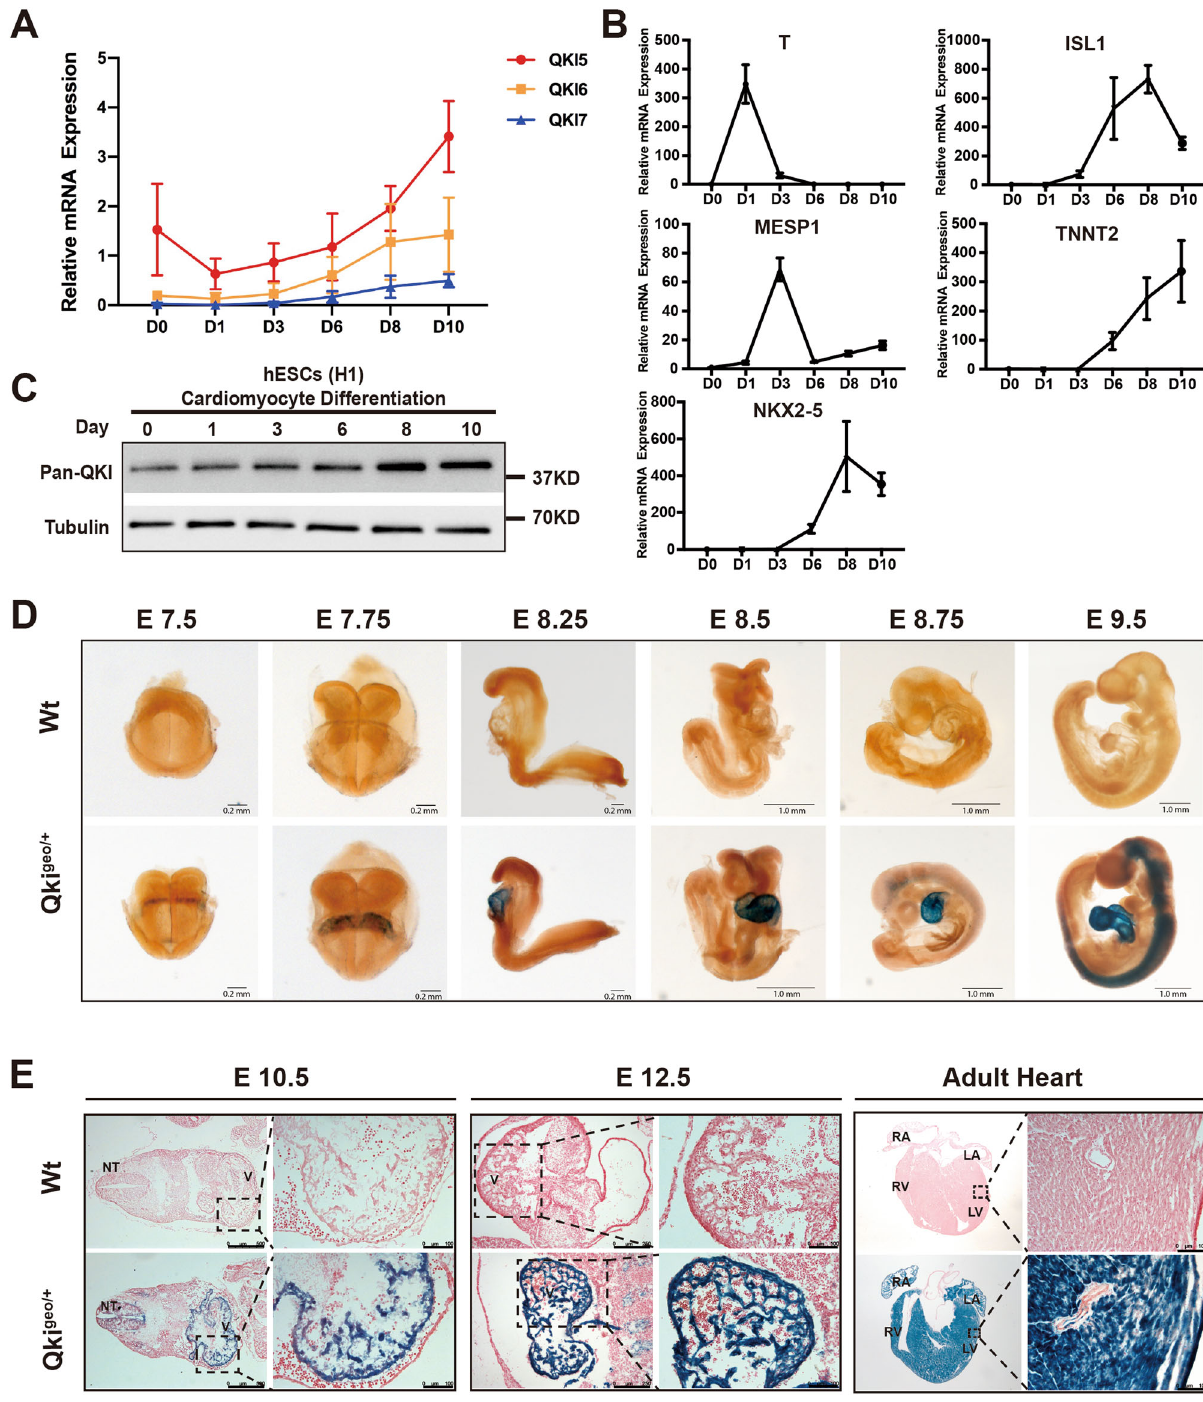
hearts from the E7.5 cardiac crescent to the four-chamber heart and the expression was persistent in both the atrial and ven- tricular myocardia (Fig. 1D, E), con fi rming that QKI was likely critical for early cardiogenic events. Cardiac Qki expression per- sisted in the postnatal hearts (Fig. 1E), further indicating a potentially important role for QKI in maintaining normal adult cardiac